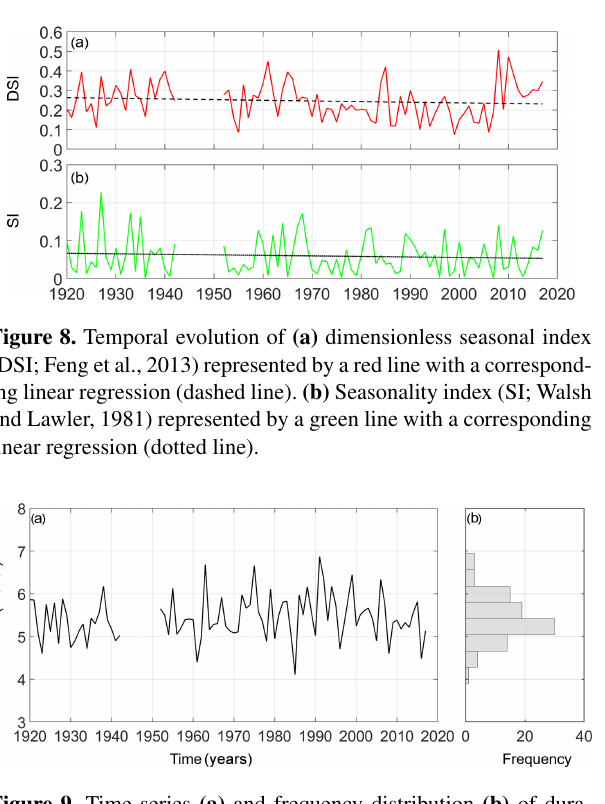
Figure 9. Time series (a) and frequency distribution (b) of dura- tions of the rainy periods at the Gioi Cilento weather station in the dynamic